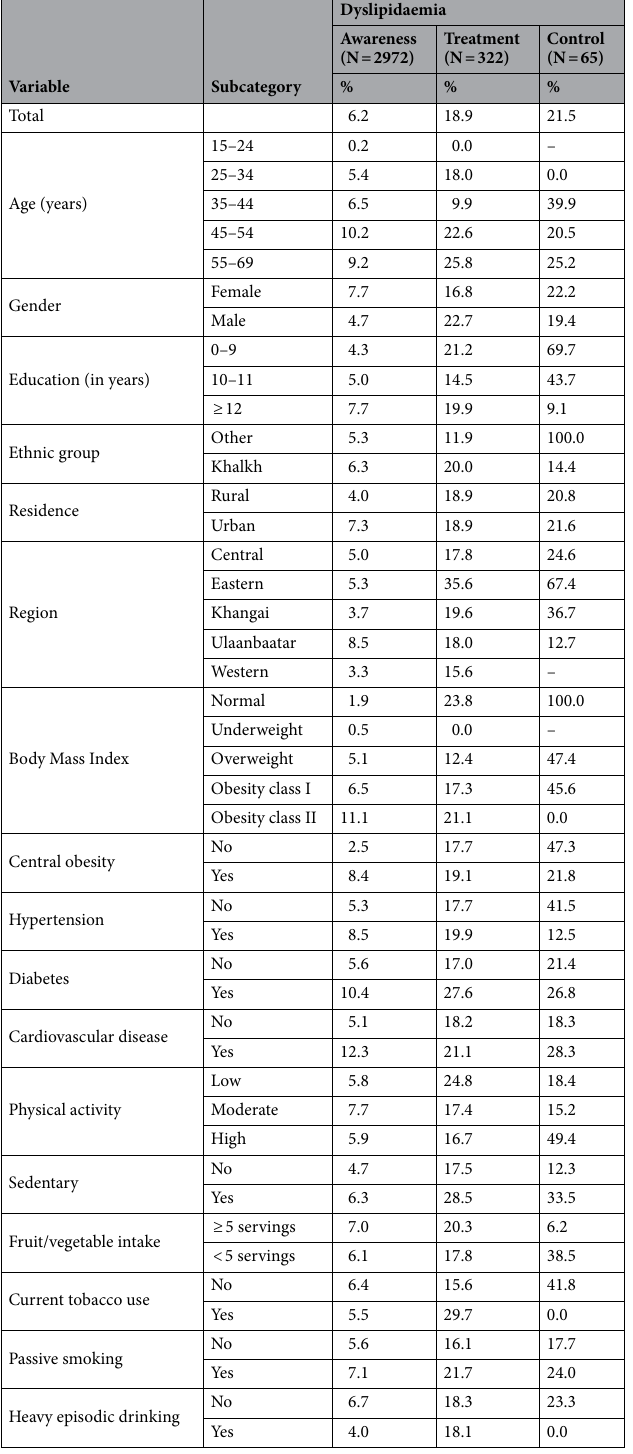
Table 2. Dyslipidaemia awareness, treatment, and